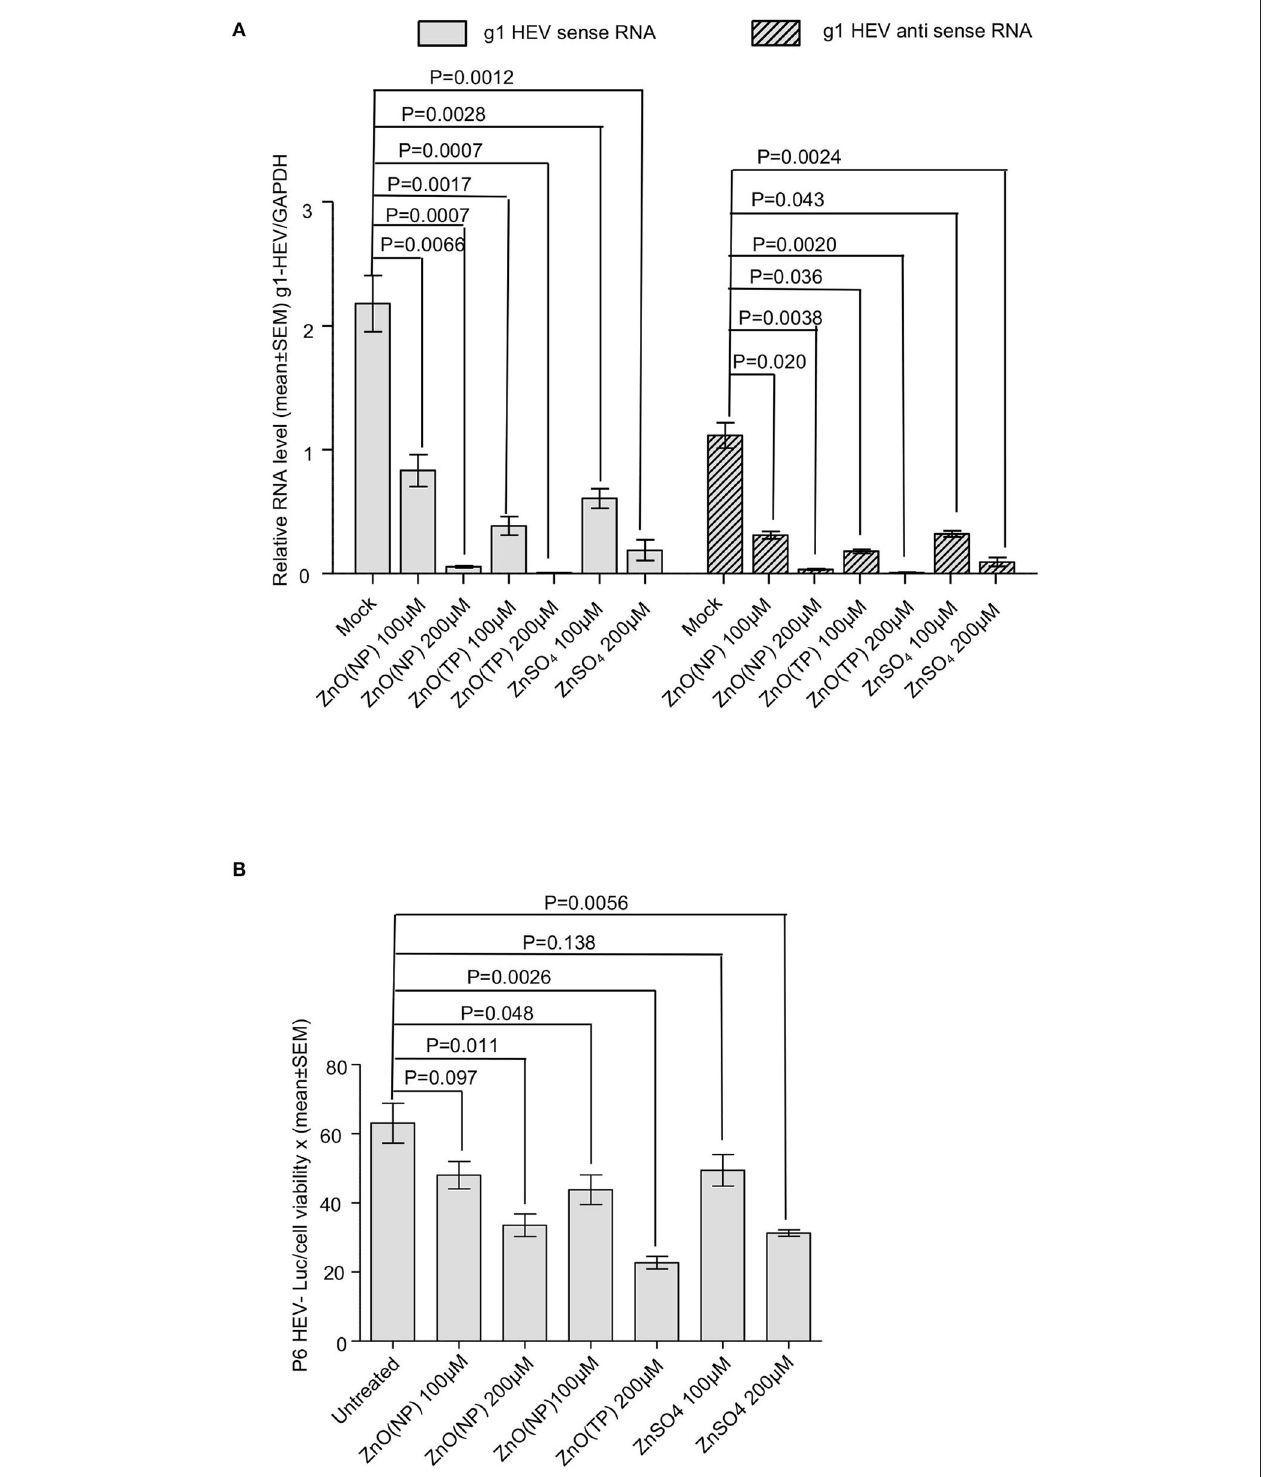
FIGURE 4 | Inhibition of HEV replication by Zinc compounds. (A) qRT-PCR detection of the HEV sense and antisense strand RNA levels in ORF4-Huh7 cells infected with a g1-HEV clinical isolate and treated for 24h with indicated concentration of ZnO(NP), ZnO(TP), and ZnSO 4. HEV sense/antisense RNA values were normalized to that of the GAPDH and represented as mean ± SEM of three independent experiments. (B) Measurement of Gaussia Luciferase (G-Luc) activity in Huh7 cells expressing in vitro -synthesized capped RNA of a g3-HEV-Luc replicon and treated for 24h with indicated concentration of ZnO(NP), ZnO(TP), and ZnSO 4 . G-Luc values were normalized to that of the cell viability and represented as mean ± SEM of three independent experiments. Mock-treated cells were used as a control.